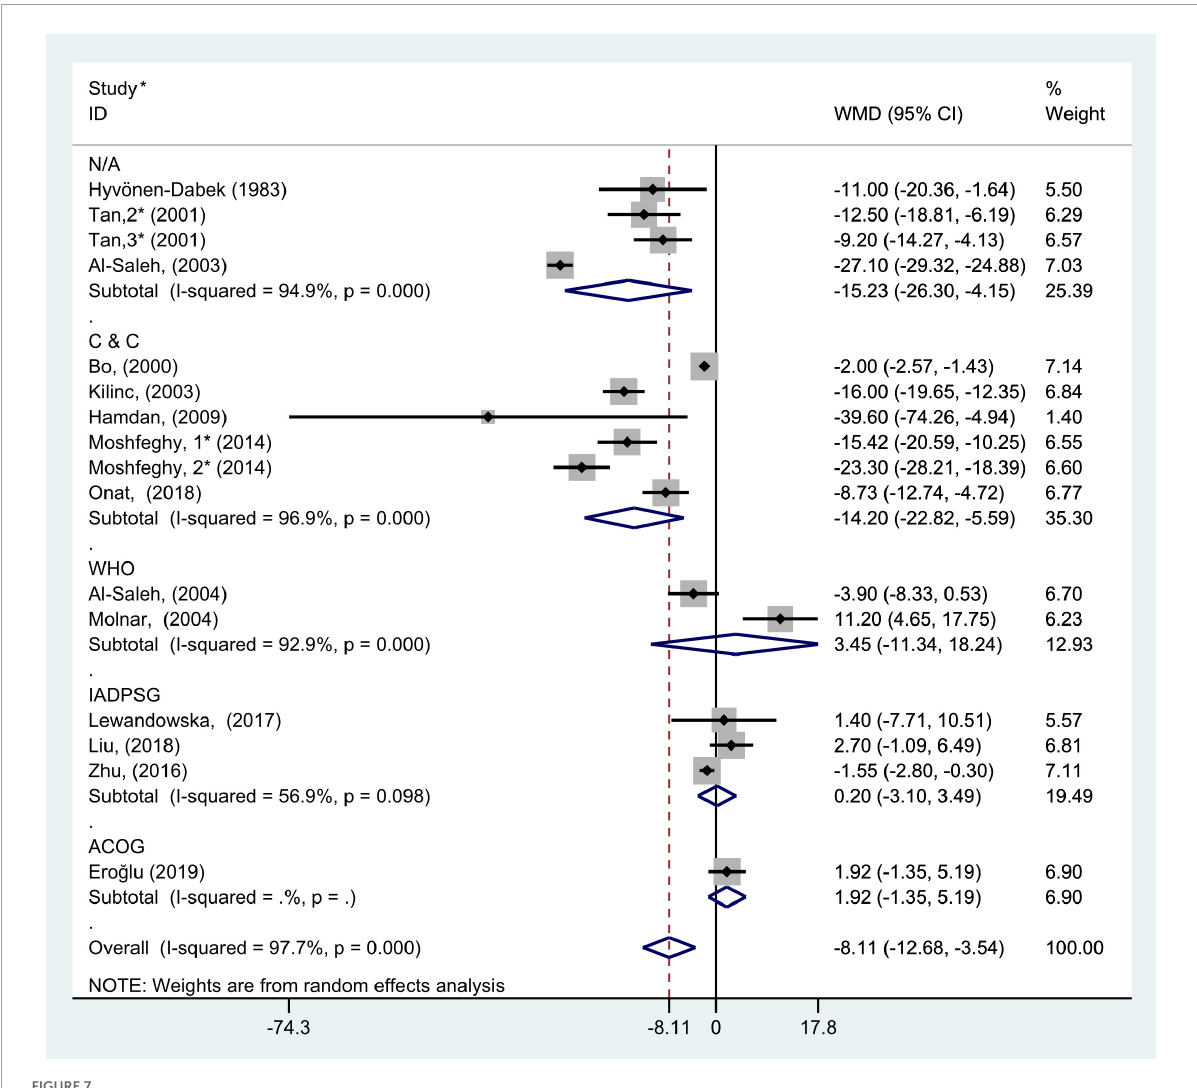
FIGURE7 Subgroup analysis of blood selenium level in patients with gestational diabetes mellitus and healthy pregnant women based on different GDM criteria. The random effect model is applied. N/A, not available or not reported; C&C, carpenter and coustan; WHO, World Health Organization; IADPSG, International Association of Diabetes and Pregnancy Study Groups; ACOG, American College of Obstetricians and Gynecologists. For studies in which blood selenium levels were measured during different pregnancy periods in one study, 1, 2, and 3 are used to denote measurements performed in the first, second, and third trimesters, respectively. *First author (year of study